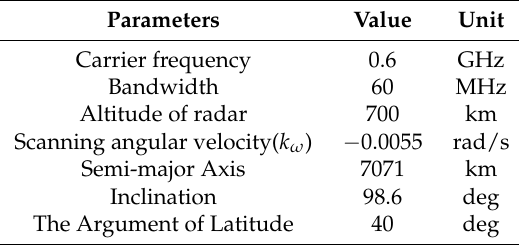
Table 2. Radar System and Orbit